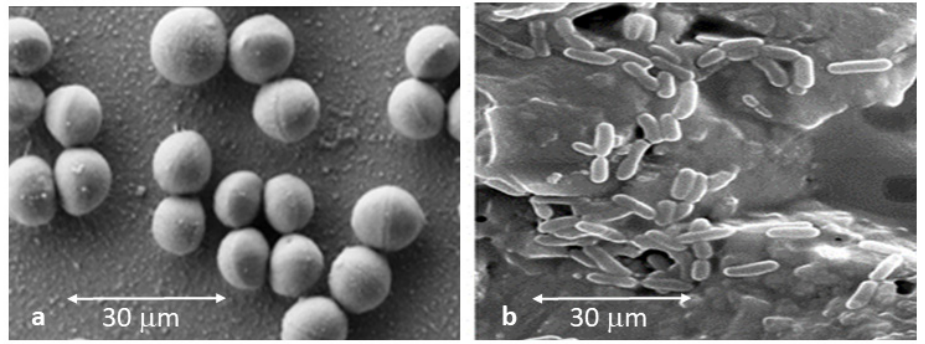
Figure 7 . Bacteria strains tested in this research: ( a ) Streptococcus sanguinis ; ( b ) Lactobacillus salivar- ius .